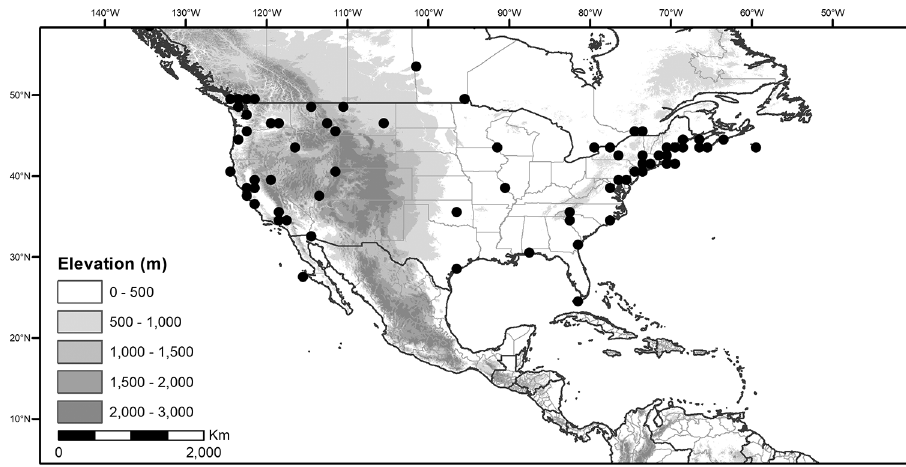
Figure 32. Distribution of Solanum nigrum